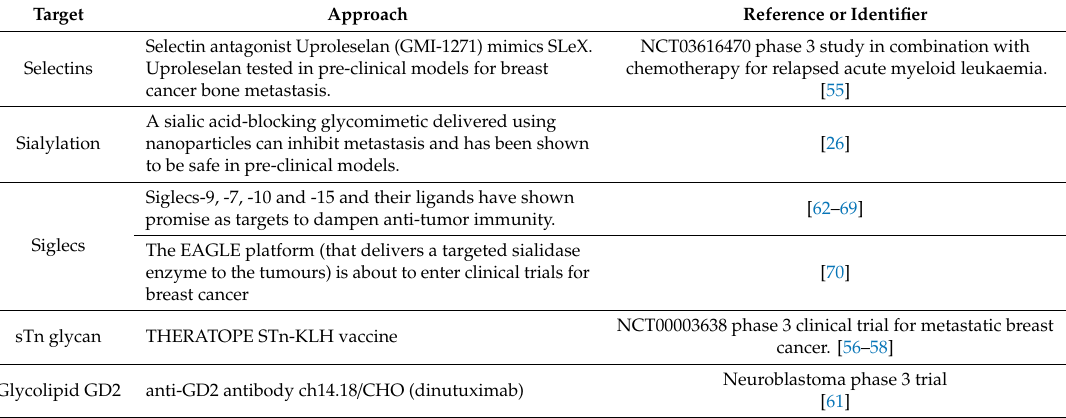
Table 2. Overview of pre-clinical models and clinical trials targeting aberrant sialylation in